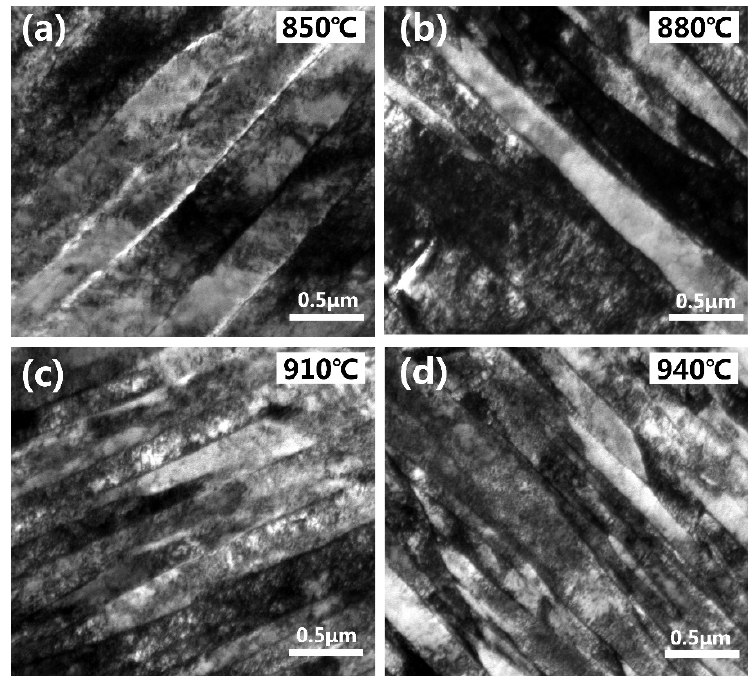
Figure 5. Transmission electron microscopy (TEM) micrographs of MCLA steel austenitized at the di ff erent temperatures: ( a ) 850 ◦ C, ( b ) 880 ◦ C, ( c ) 910 ◦ C, and ( d ) 940 ◦ C.